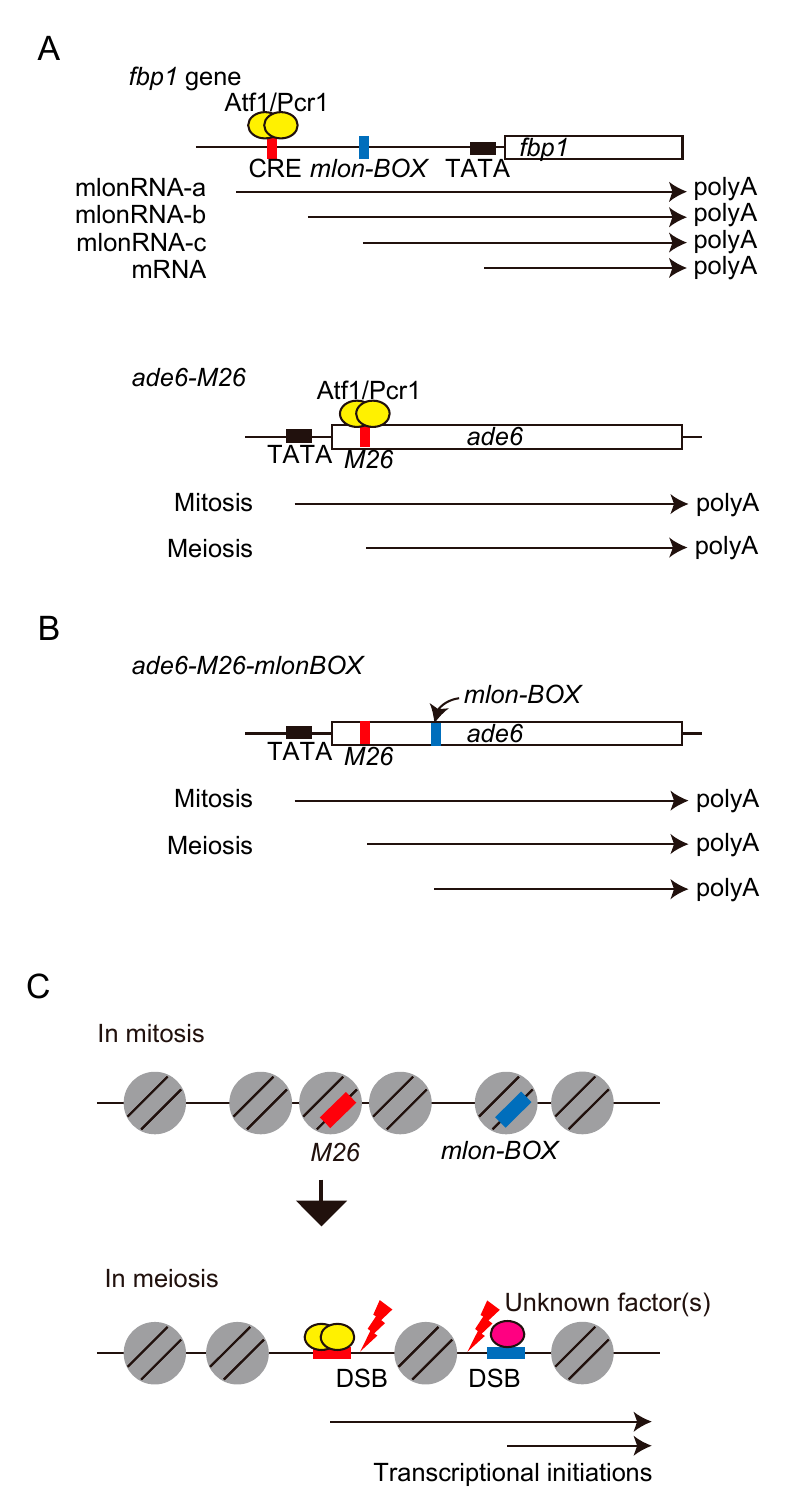
Figure 5. The conserved role of promoter-lncRNAs, mlonRNAs identified in the upstream region of fbp1 during the regulation of chromatin. ( A ) Schematic representation of mlonRNA transcriptions from the fbp1 and ade6 loci. In the fbp1 locus, during glucose rich condition, the longest mlonRNA (mlonRNA-a) is weakly expressed. Initially, during glucose starvation (10–20 min of glucose starvation), mlonRNA-b and -c are progressively expressed. At 60–180 min of glucose starvation, fbp1 mRNA is massively induced. mlon-BOX (mlonRNA-c initiation element), is located approximately 100 bp upstream from mlonRNA-c transcription start site. Notably, mlon-BOX is around 200 bp downstream from the Atf1 binding site (CRE). Red, blue, and black boxes show CRE, mlon-BOX , and TATA-BOX, respectively. In the ade6 locus, during mitotic cell phase, mRNA is expressed from TATA-BOX. During meiosis, the transcription initiation site is shifted to the CRE site. ( B ) Schematic representation of ade6 gene locus. Position of TATA-box, M26 , and the insertion point of mlon-BOX are indicated by black, red and blue boxes, respectively. The ade6 mRNA and transcripts induced from the M26 site or mlon-BOX are indicated by arrows. ( C ) Chromatin configuration around M26 site and mlon-BOX insertion point. Transcriptional activations occur form M26 site and mlon-BOX insertion point in meiosis. Then, chromatin configuration changes to open state and DSBs are in- duced at the M26 site and mlon-BOX insertion point. The DSB sites are shown.